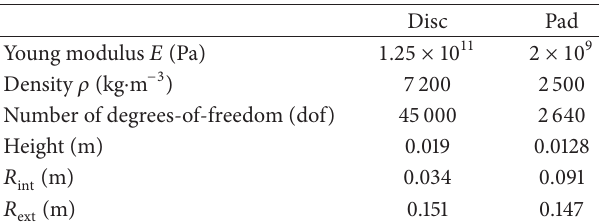
Table 1: Finite element details and material and geometric proper- ties of the simplified brake